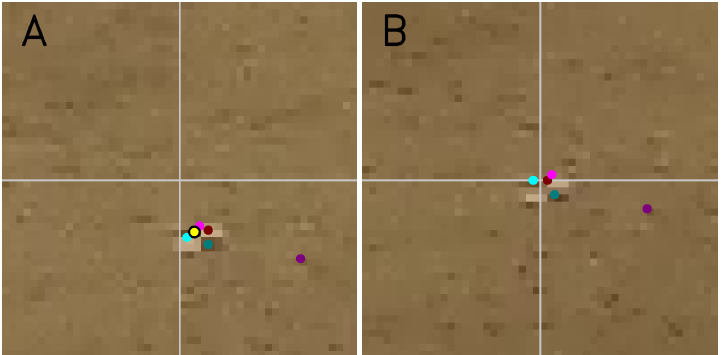
Figure 5. GCP tracking after the homography. The center of ( A ) corresponds to the center of ( B ) (where the GCP is) through the homography. The colored dots are the ORB pairs that allow to know the required translation to find the GCP in A (yellow